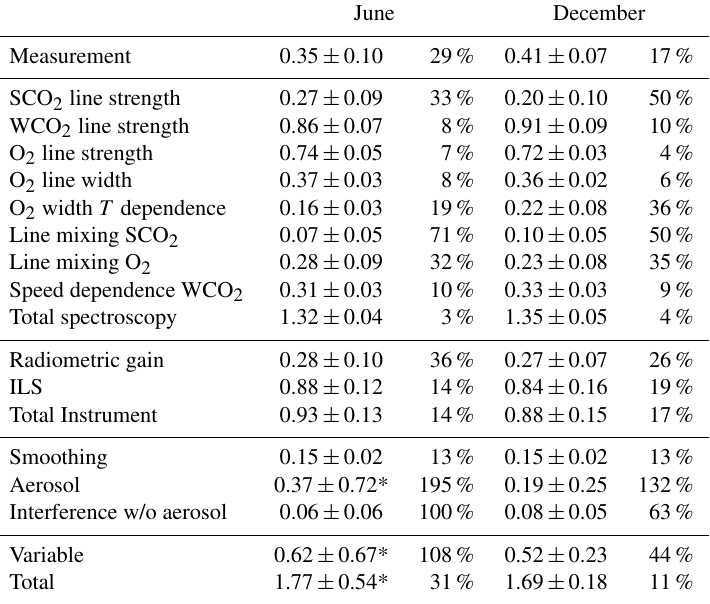
Table 4. Global mean errors in XCO 2 and standard deviations for ocean glint observations. The coefficient of variation (relative standard deviation) is also